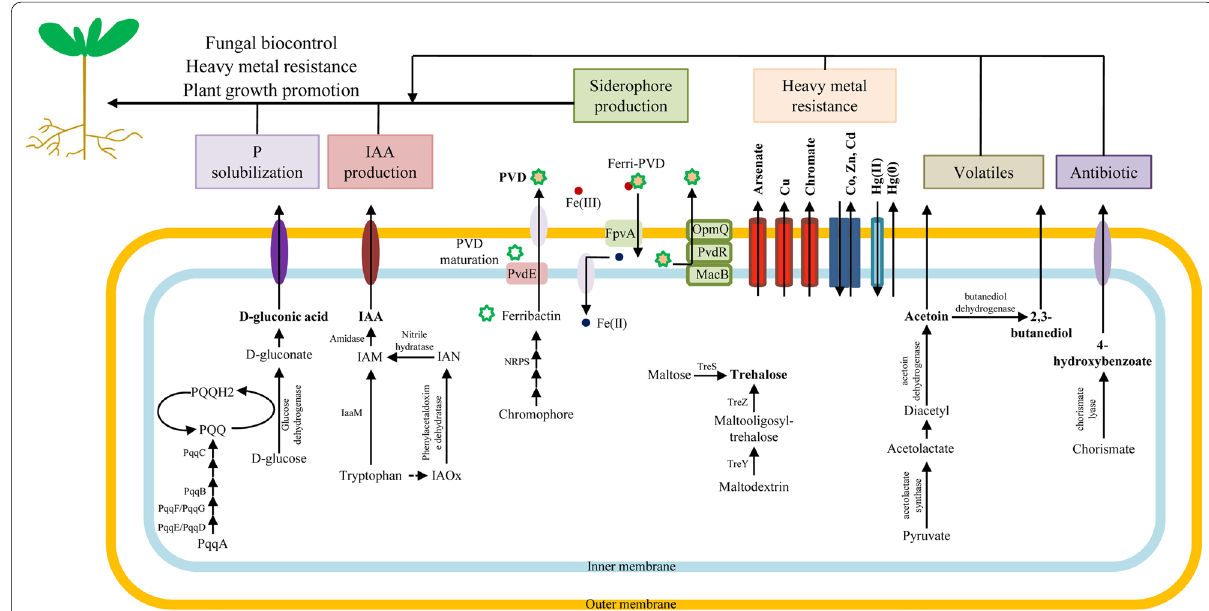
Fig. 7 Speculated schematic summary of metabolic pathways involved in plant growth promotion, heavy metal resistance, and fungal biocontrol in P. putida LWPZF. The texts above or on both sides of the arrows represent enzymes catalyzing each reaction steps which were identified in the LWPZF genome. The ORF ID of these enzymes were shown in Additional file 1: Table S4. The PVD transport process was modified according to the publication of Imperi et al (2009). PQQ, pyrroloquinoline; PQQH2, pyrroloquinoline quinol; IAM: indole-3-acetamide; IaaM: